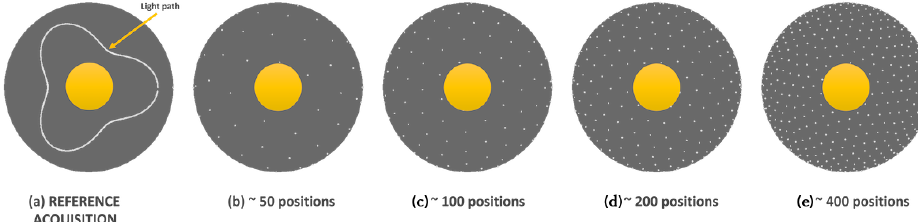
Figure 4. ( a ) Chosen light path. ( b – e ) Acquisition positions associated with parameter P 2